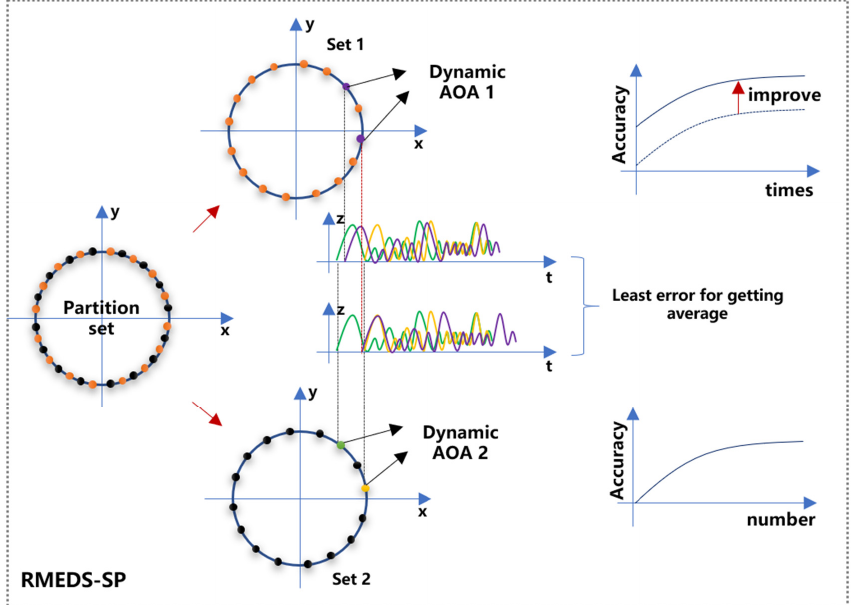
Figure 6. The models and performance of RMEDS-SP.